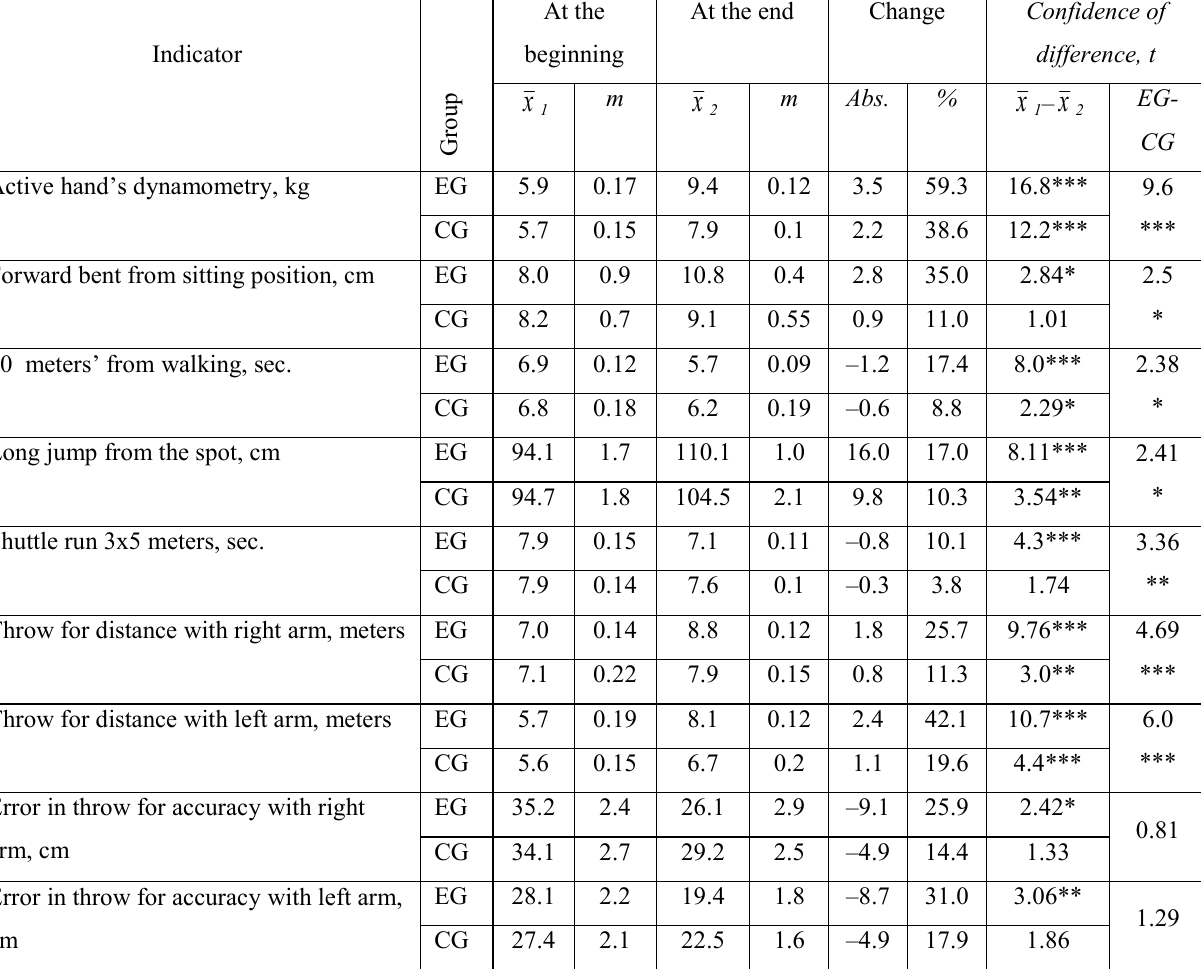
Change of motor skills’ indicators in tested groups of boys with RMA in the course of forming experiment Indicator